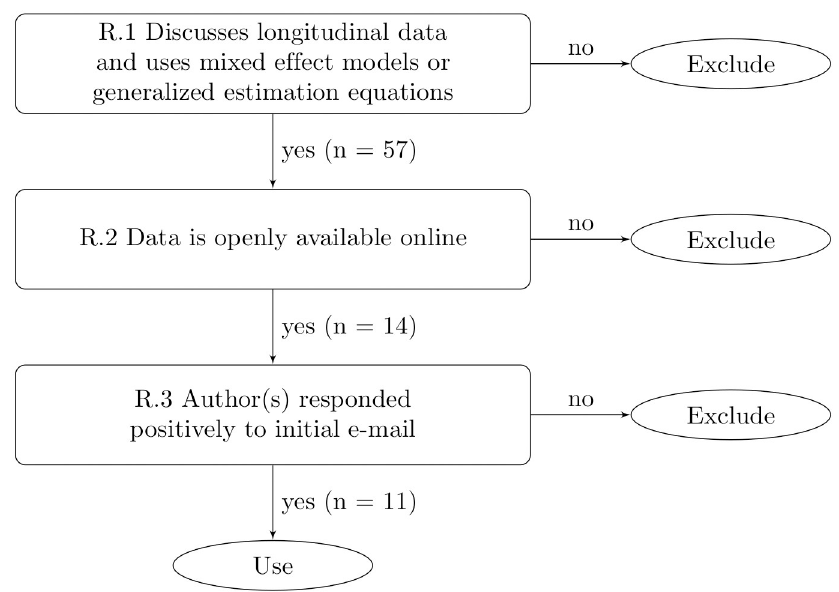
Fig 1. Data selection. Data selection procedure according to our requirements and number of papers fulfilling the respective